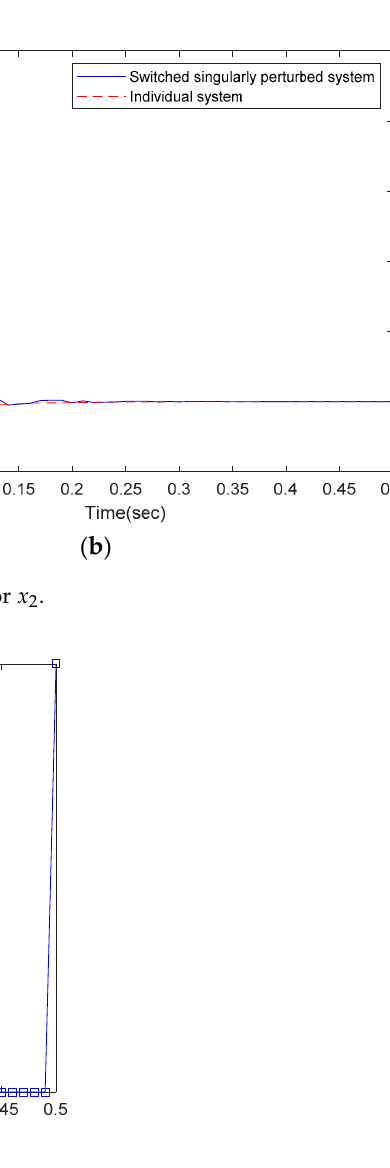
Figure 3. The switching signal.